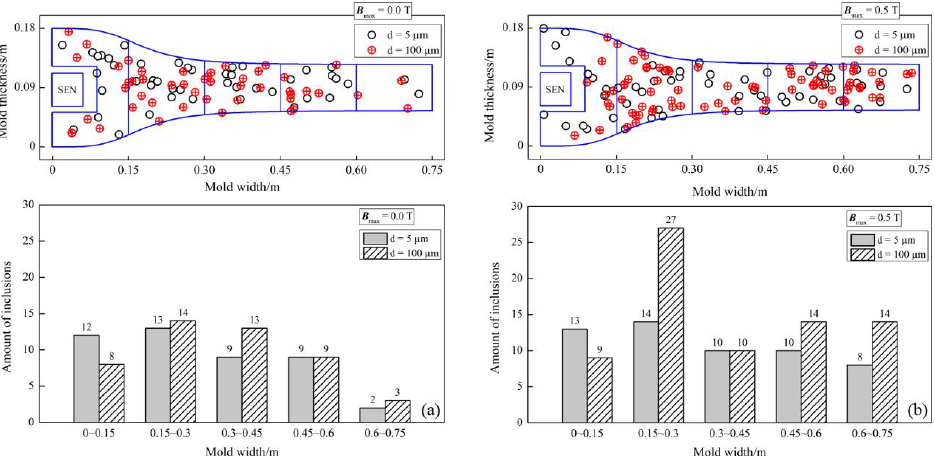
Figure 19. Inclusion distribution on the free surface in the CSP mold: ( a ) B max = 0 T and ( b ) B max = 0.5 T.